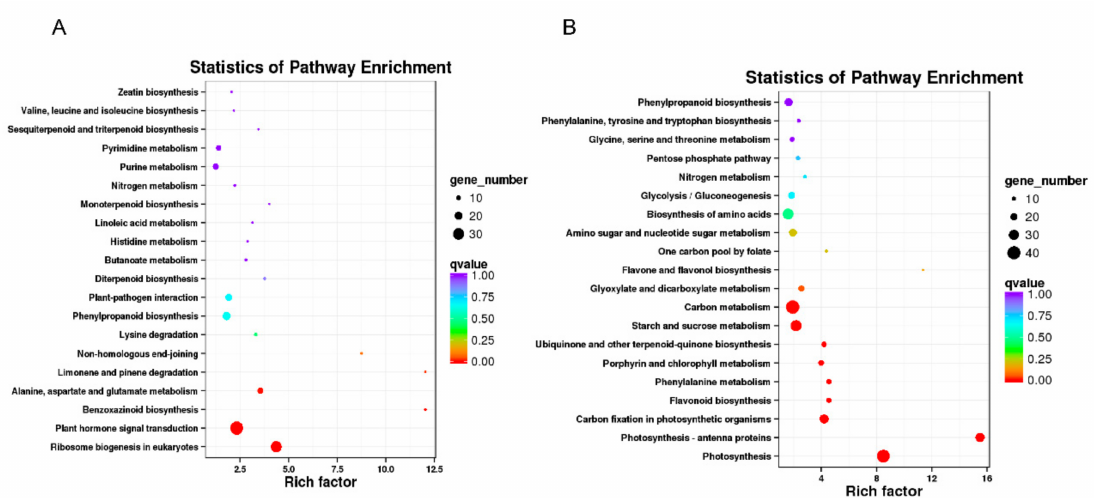
Figure 12. Enriched Kyoto encyclopedia of genes and genomes (KEGG) pathway enrichment of DEGs between dnl2 and the wild-type. Enriched KEGG pathways of up-regulated DEGs ( A ) and down-regulated DEGs ( B ) in dnl2 compared with the wild-type. The point size represents the number of genes in the pathway; the color depth indicates the q